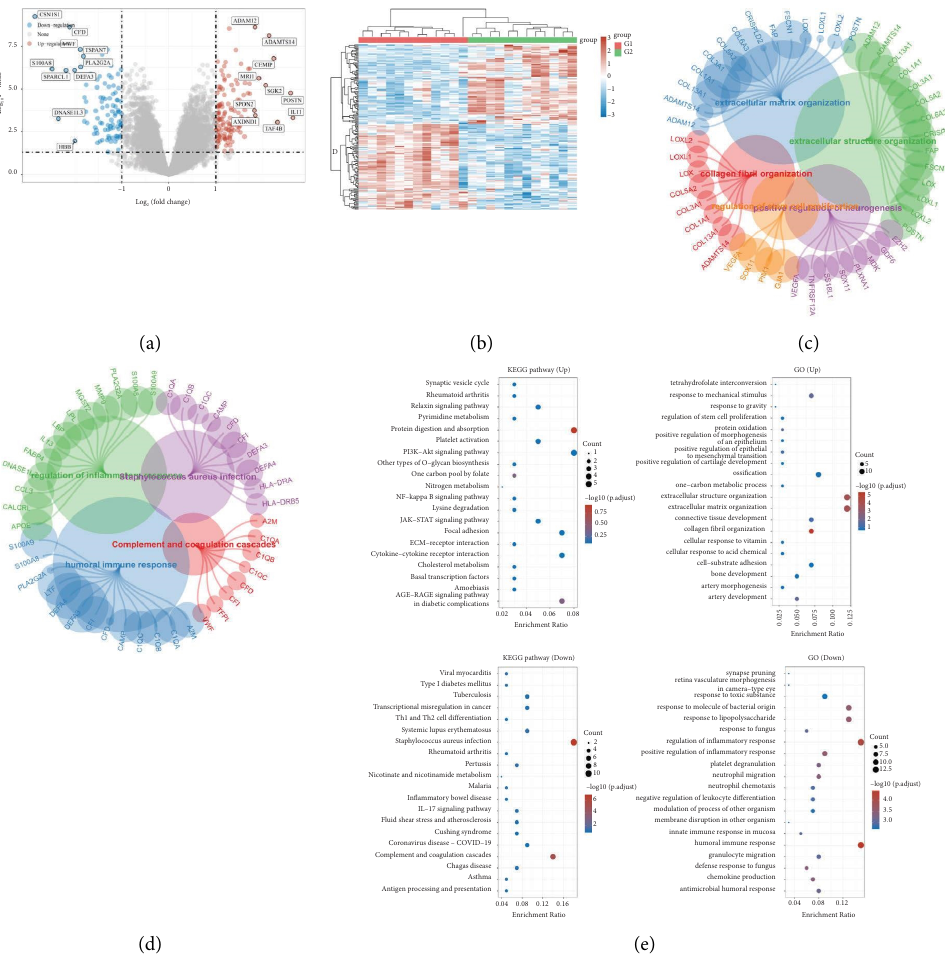
Figure 1: (a) Te volcano map demonstrated the DEGs between OA patients and normal cohort. (b) Te heatmap demonstrated the DEGs between OA cohort and normal people. (c) Te GO enrichment analysis. (d) Te KEGG enrichment analysis. (e) Te pathway enrichment analysis based on the DEGs.